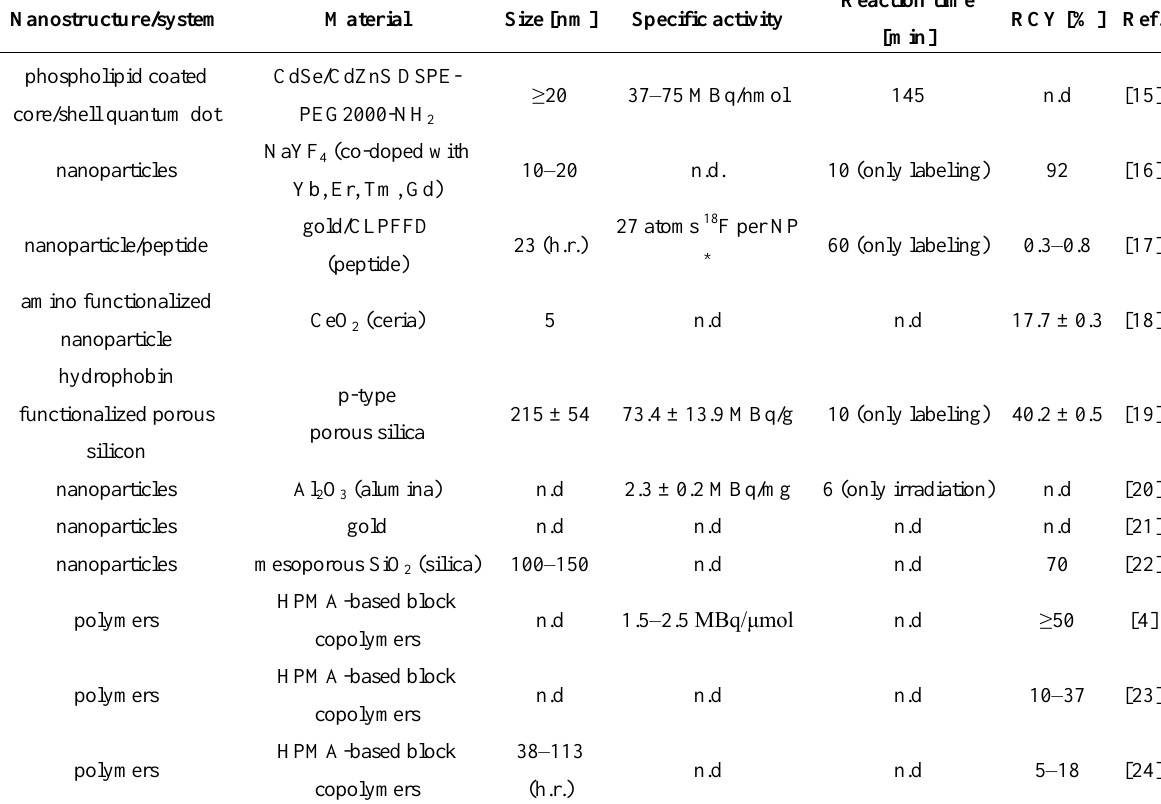
= 1,2-distearoyl- sn 2